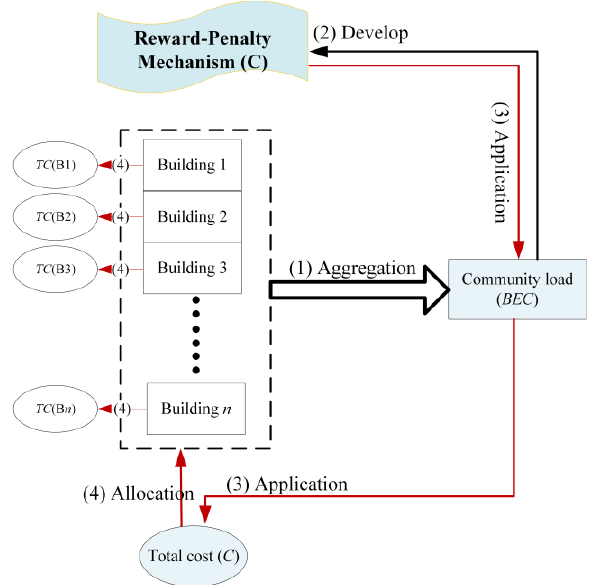
Fig. 1. Schematic diagram of community-level RPM.